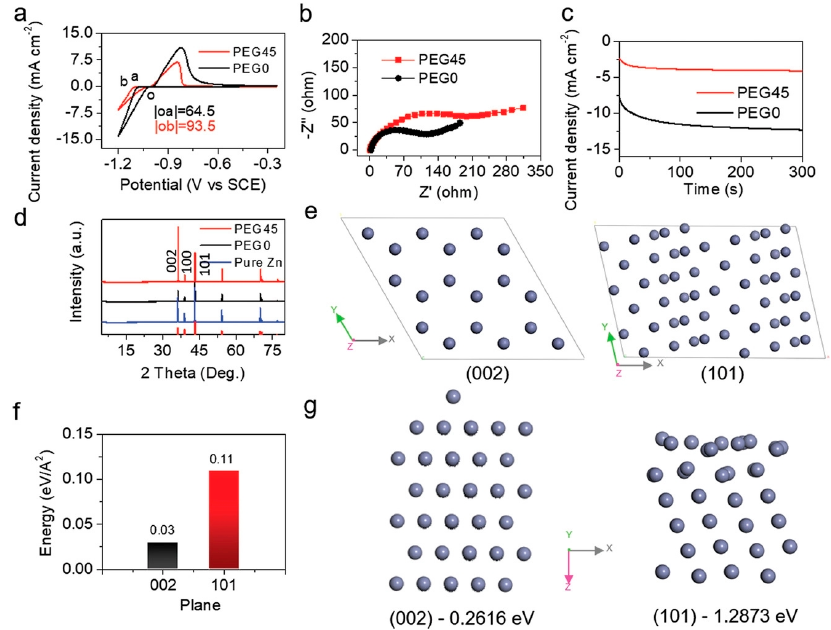
Figure 12. ( a ) CV curves of Zn nucleation on bare Ti foil in the various electrolytes. ( b ) EIS of Zn//Zn cells with various electrolytes. ( c ) Chronoamperograms of Zn foil in PEG0 and PEG45 at − 150 mV overpotential. ( d ) XRD patterns of Zn//Zn cells in PEG0 and PEG45 after 100 cycles at 0.25 mA cm − 2 and 0.125 mAh cm − 2 . ( e ) Distribution of atoms at the plane (002) and (101). ( f ) Surface energy for the plane (002) and (101). ( g ) Adsorption energy calculations of free zinc atom at the plane (002) and (101). Reproduced with permissions from Ref. [97]. Copyright © 2022 WILEY-